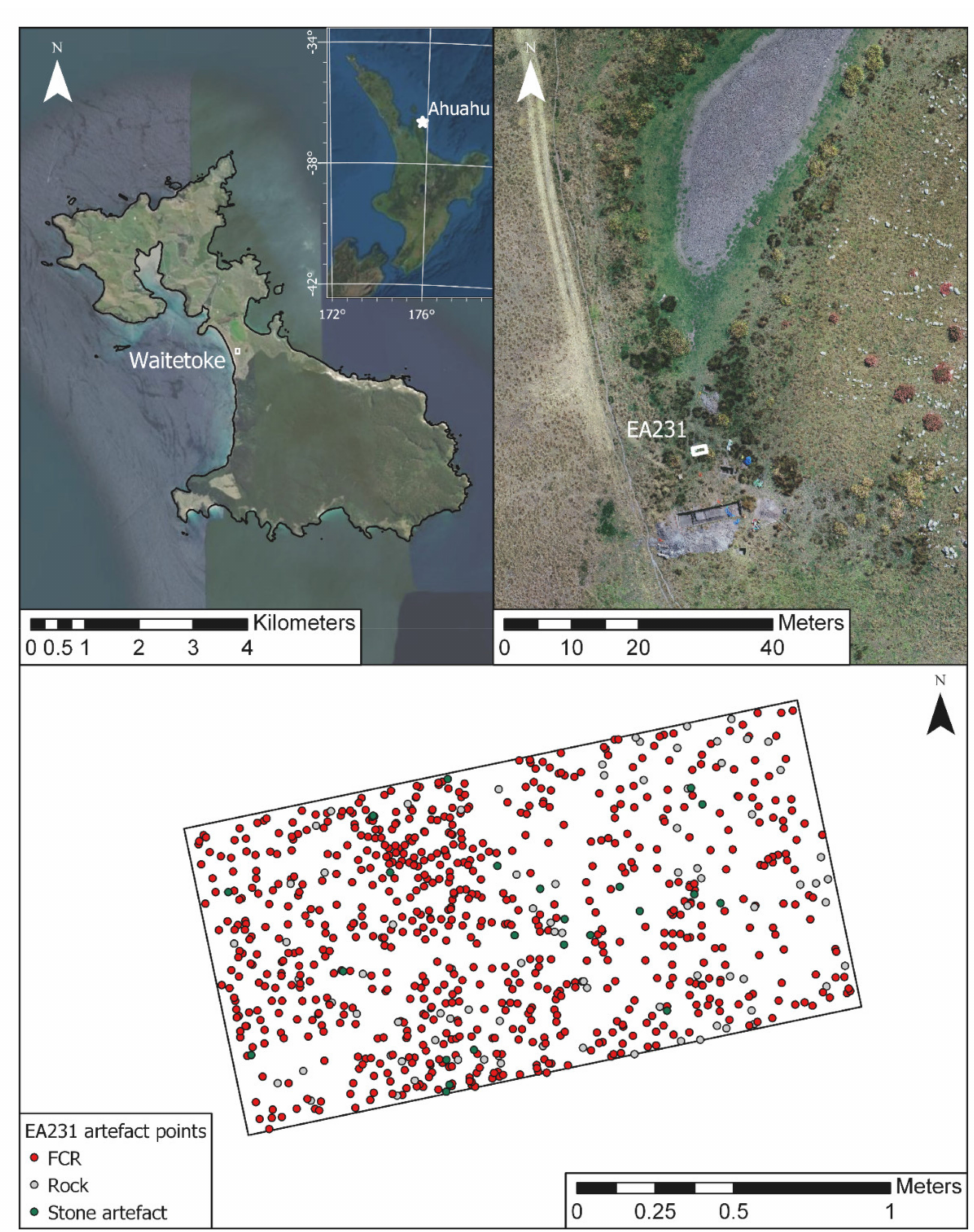
Figure 1. Location of Ahuahu Great Mercury Island and Waitetoke, with the distribution of all artefacts and features recorded from EA231. FCR = fire-cracked